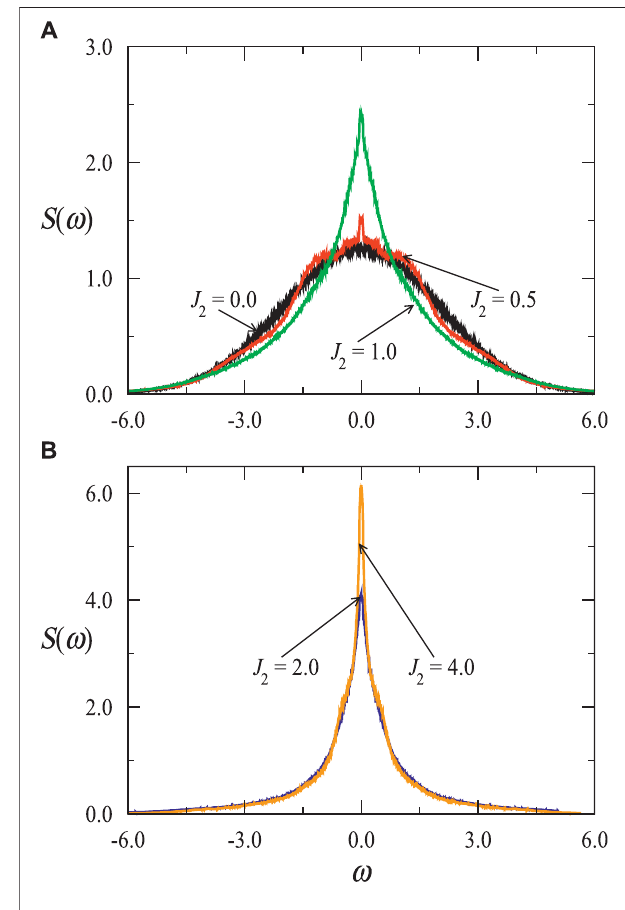
FIGURE6| Spectral density for B (cid:2) 1and severalvalues of J 2 , obtained for chains of length L (cid:2) 13. [From Ref. 17.]